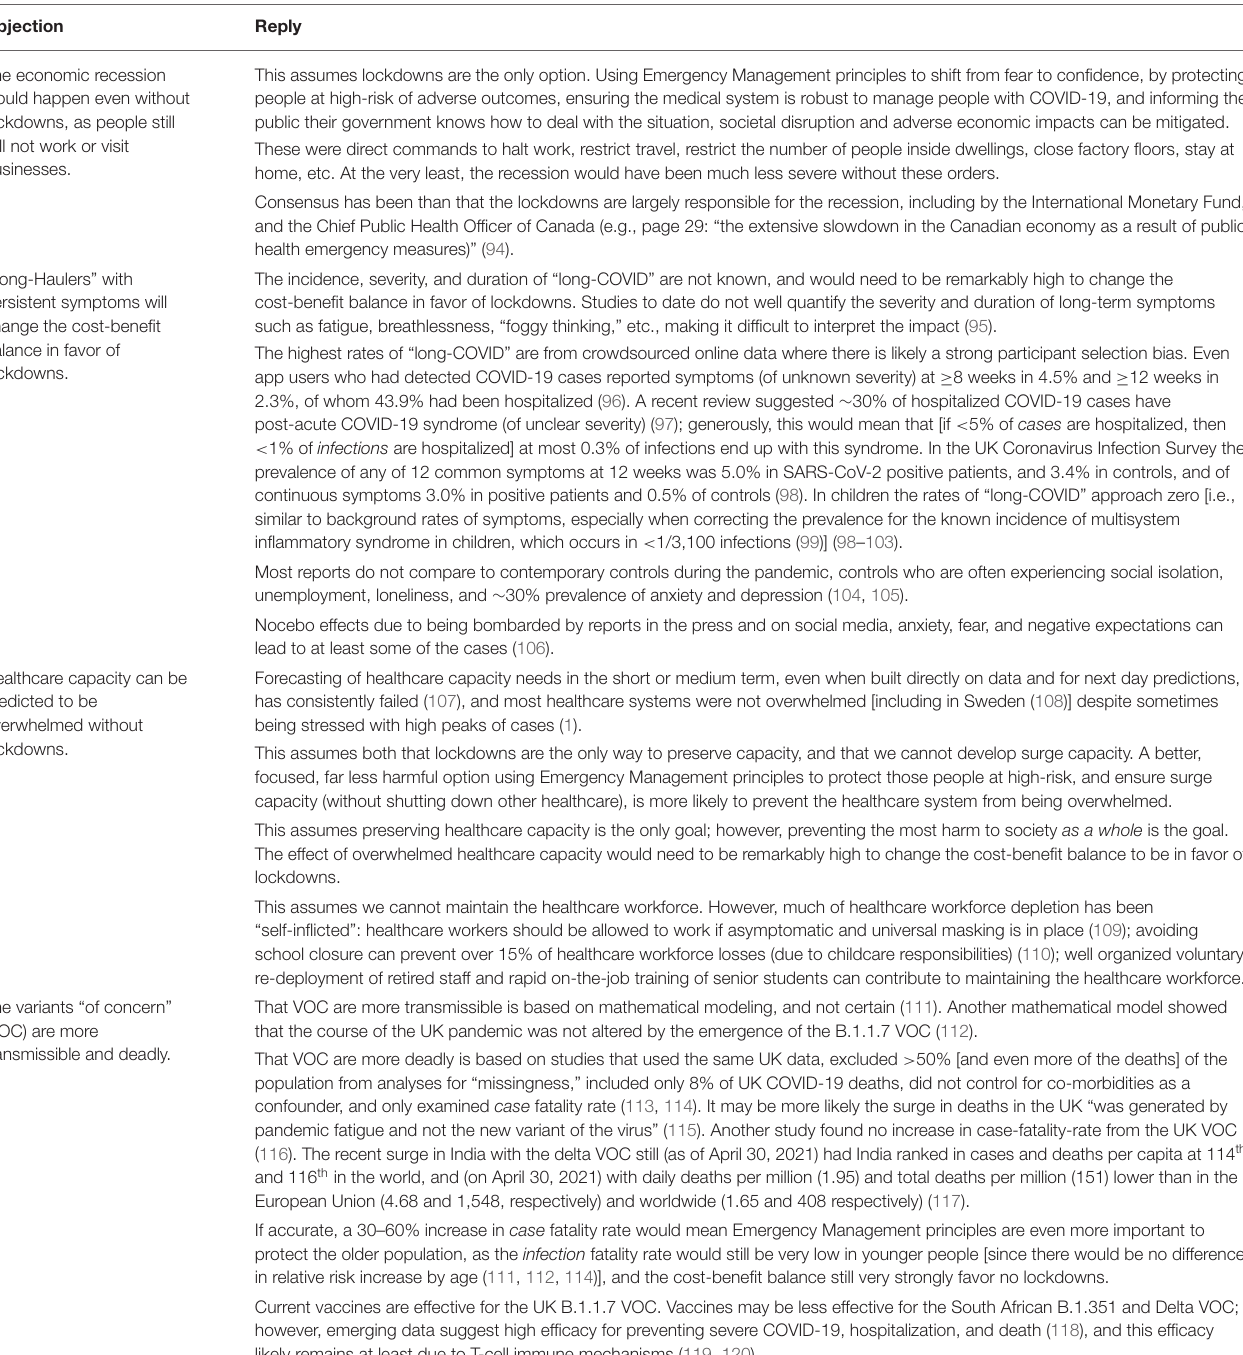
TABLE 6 | Common objections considered regarding the cost-benefit of lockdowns. Objection Reply